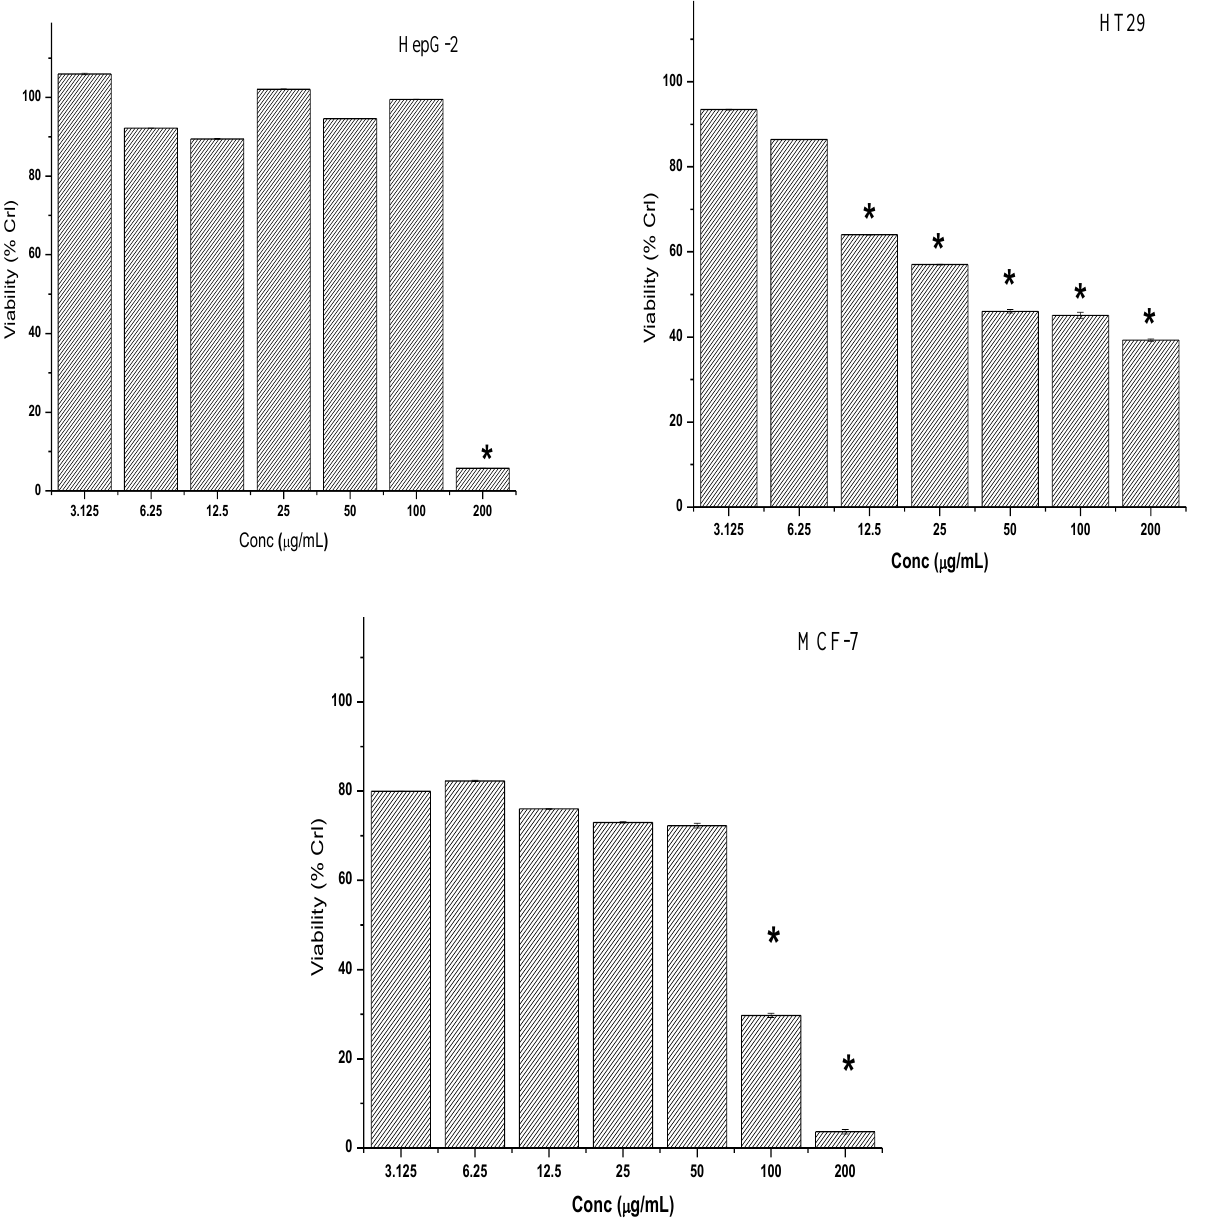
Figure 6. Cytotoxic effect of the chloroform extract on HepG2, HT-29 and MCF-7 cancer cell lines. Cells were exposed to increasing concentrations of the crude extracts for 72 h. The results of the three independent tests are shown as the mean ± SD. * Asterisk indicates significant difference at p < 0.005.